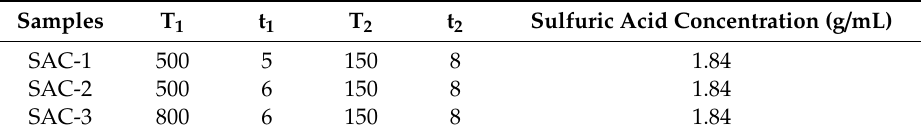
Table 1. Synthesized conditions of biochar-based solid acid